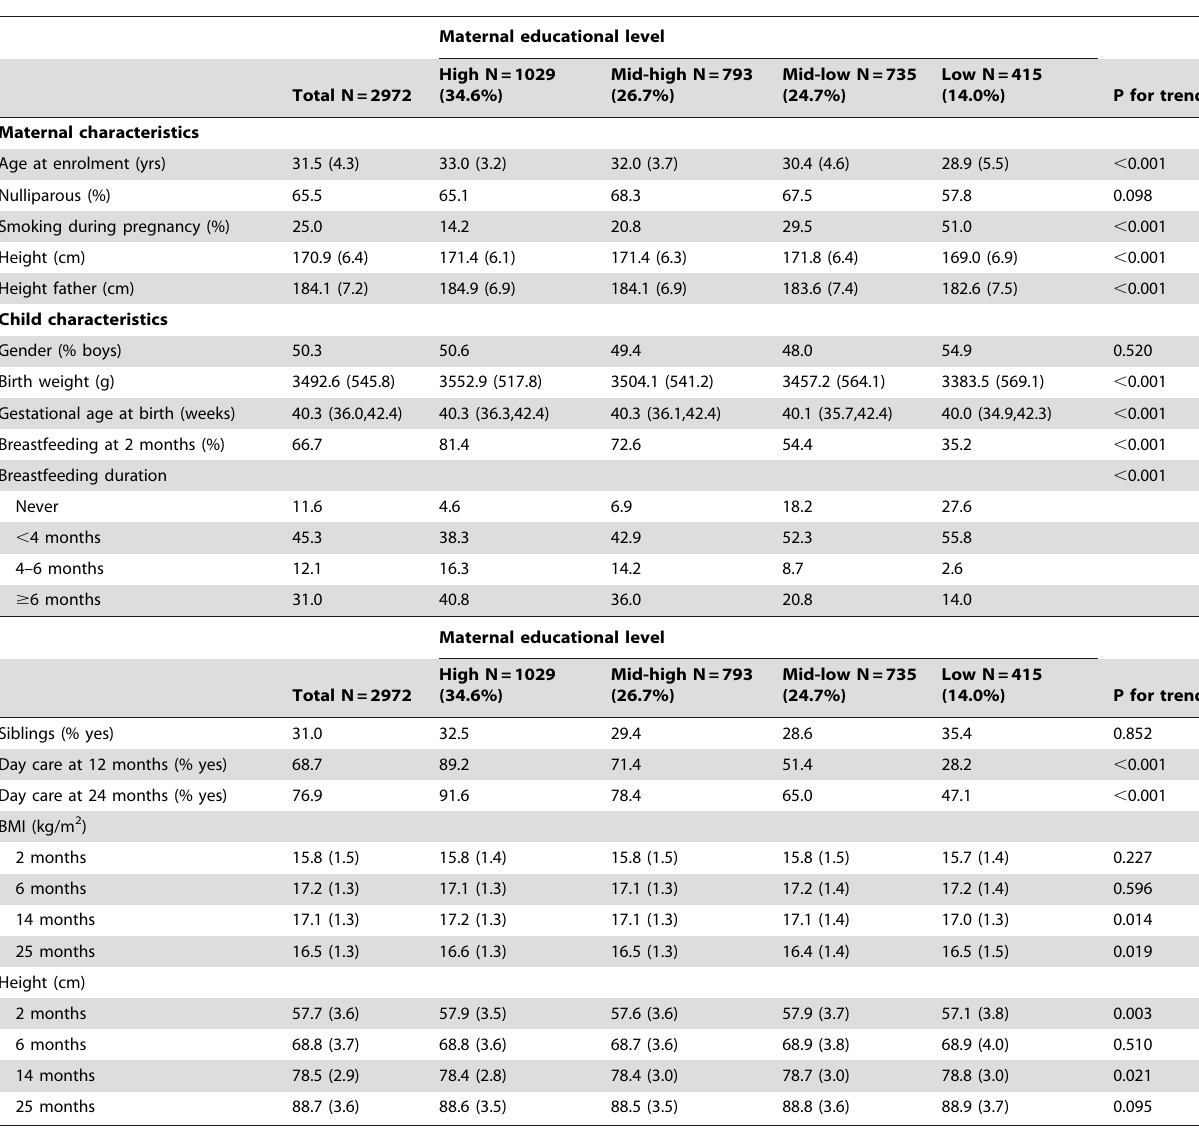
Table 1. General characteristics of the study population (n